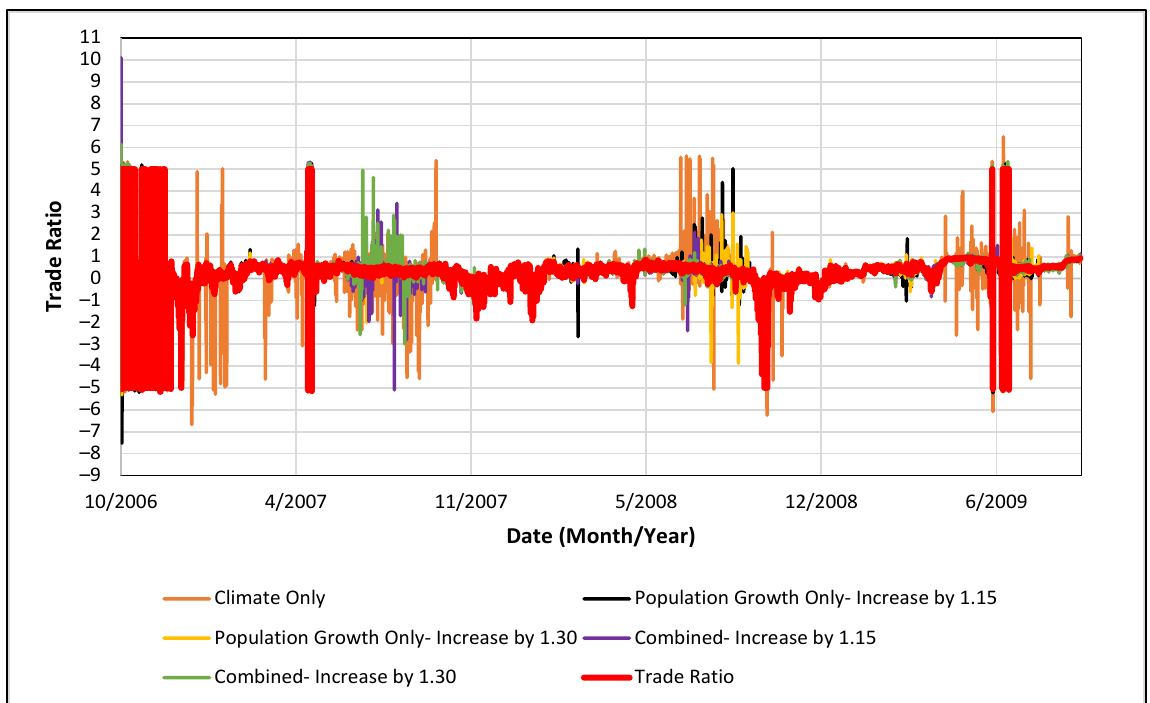
Figure 9. Composite Trade Ratio based on Sums for Delivery + Downstream Components with Equivalency Adjustments for Theoretical WQT Buyer TP Combined with Suggested Margins of Safety for Climate and Population Characteristics over the Jordan River Simulation Period (1 October 2006 to 30 September 2009) for RCP 4.5.